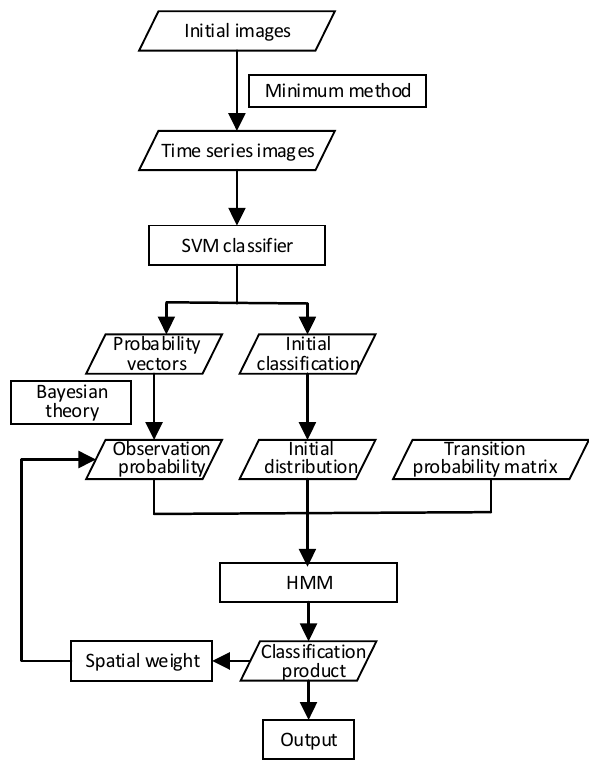
Figure 3. Algorithm flow chart.